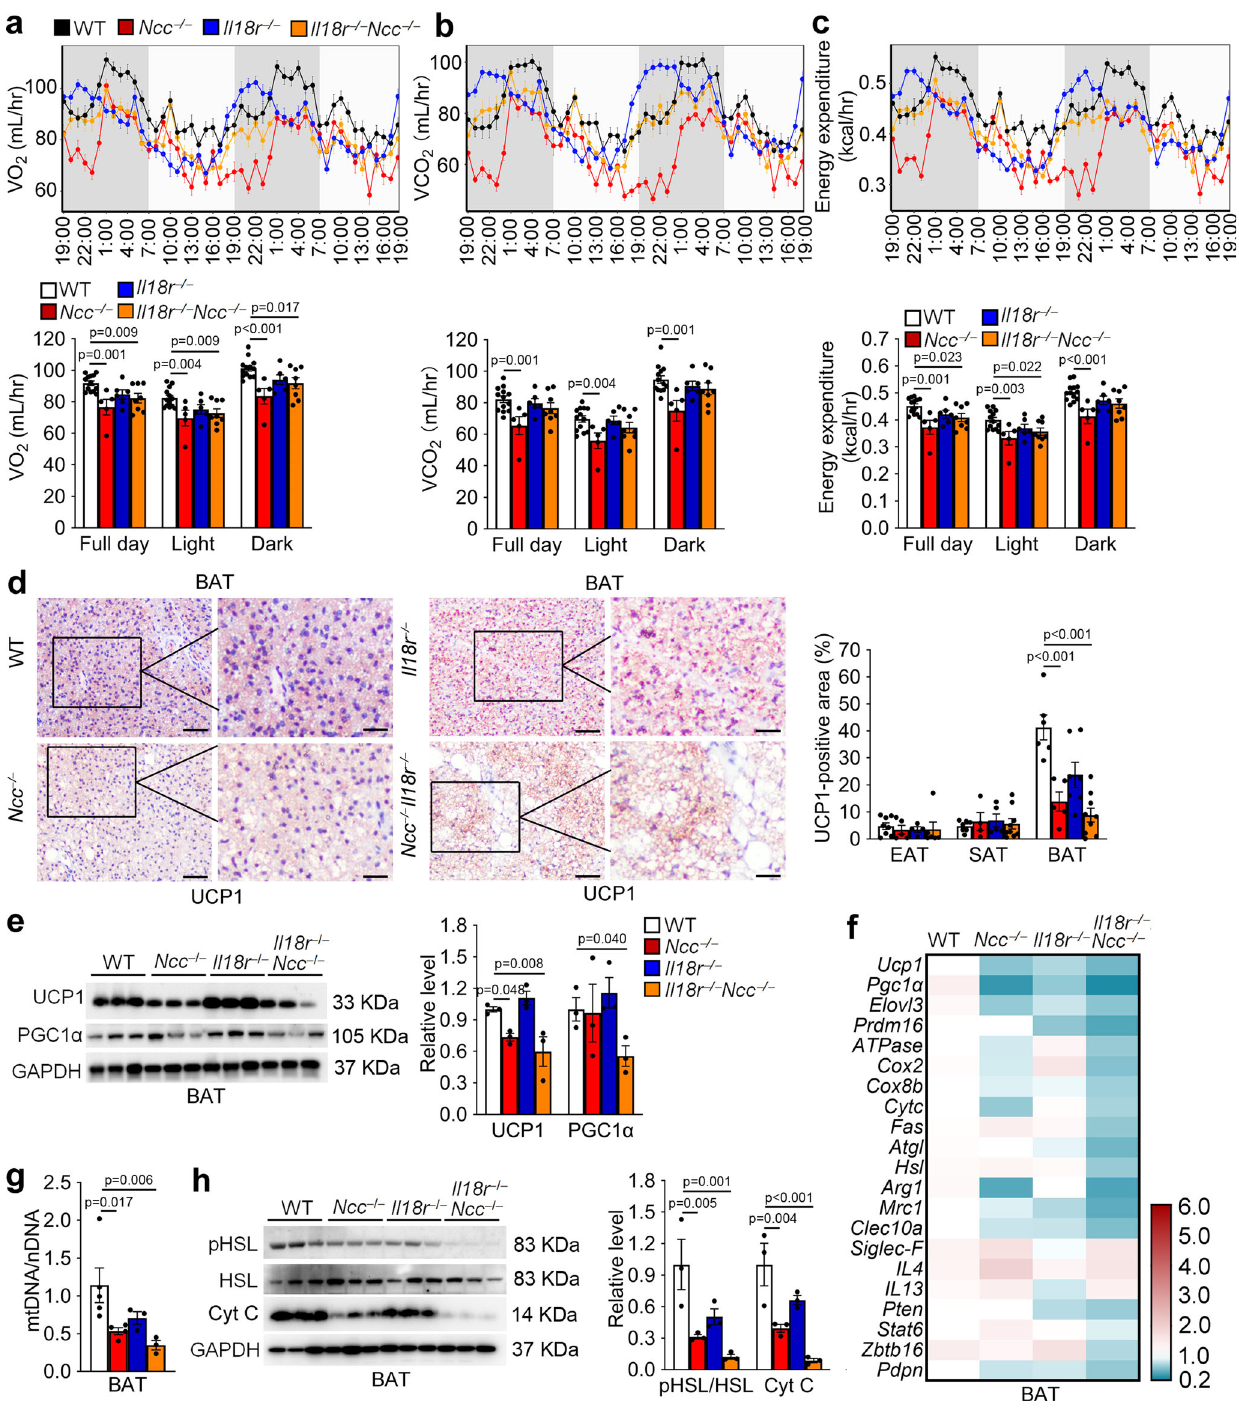
Fig. 4 | Impaired energy expenditure, and decreased lipolysis and mitochon- drial activity in BAT from Ncc − / − and Il18r − / − Ncc − / − mice in response to CL316243. a – c Mousemetabolicparameters,includingoxygenconsumption(VO 2 )( a ),carbon dioxide production (VCO 2 ) ( b ), and energy expenditure ( c ) and their average valuesfromfulldaycycle,lightcycle,anddarkcycleduring48hrsofmonitoringin WT, Ncc − / − , Il18r − / − , and Il18r − / − Ncc − / − mice after 7 days of CL316243 treatment (WT: n =13; Ncc − / − : n =5, Il18r − / − : n =6; Il18r − / − Ncc − / − : n =8). d . Representative images of UCP1immunostainingofBATsectionsandUCP1-positiveareainEAT,SAT,andBAT from indicated groups of mice (WT: n =7; Ncc − / − : n =5, Il18r − / − : n =5; Il18r − / − Ncc − / − : n =6).Scale:50 μ m,inset:25 µ m. e Immunoblotanalysisandquanti fi cationofUCP1